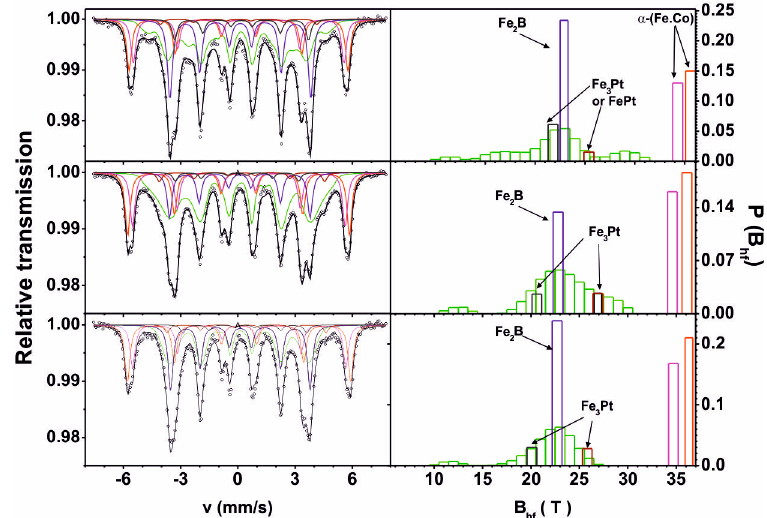
Figure 2. Mössbauer spectra of the samples of the investigated alloys: Fe 61 Co 10 B 20 W 1 Y 8-x Pt x (where x = 3, 4, 5). Positions of the sub-spectral lines relate to the α -(Fe,Co), α -(Fe,Co)B, Fe 2 B, FePt, and iron-rich Fe 3